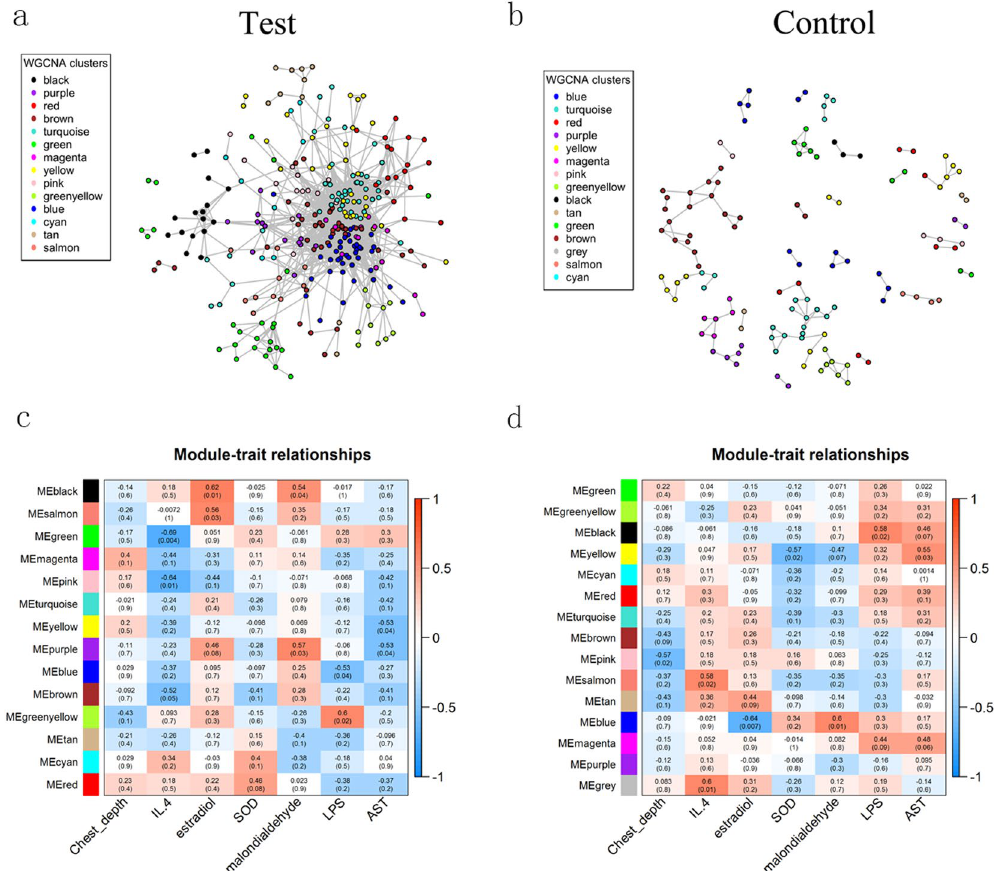
Figure 6. Construction of OTU co-occurrence network and module-trait associations of cecal microbiota of the RLF and RPMF ducks. ( a , b ) OUT co-occurrence network was constructed. OTU ( nodes ) are represented according to WGCNA module colors. ( c , d ) Module-trait associations are shown. Each cell of the matrix contains the correlation between one OTU module and a trait and the corresponding p value. Red and blue colors represent positive and negative correlations, respectively. IL.4 , Interleukin 4; SOD , Superoxide dismutase; LPS , Lipopolysaccharide; AST , Aspartate